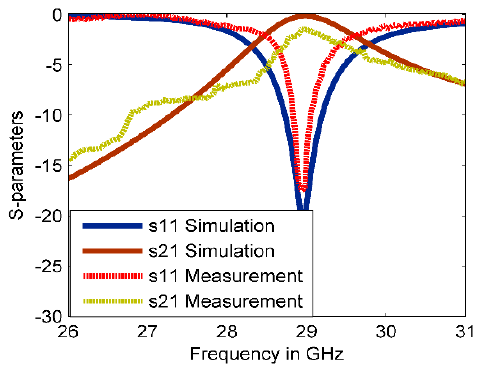
Figure 2. Reflection and transmission coefficients of the CSR structure.